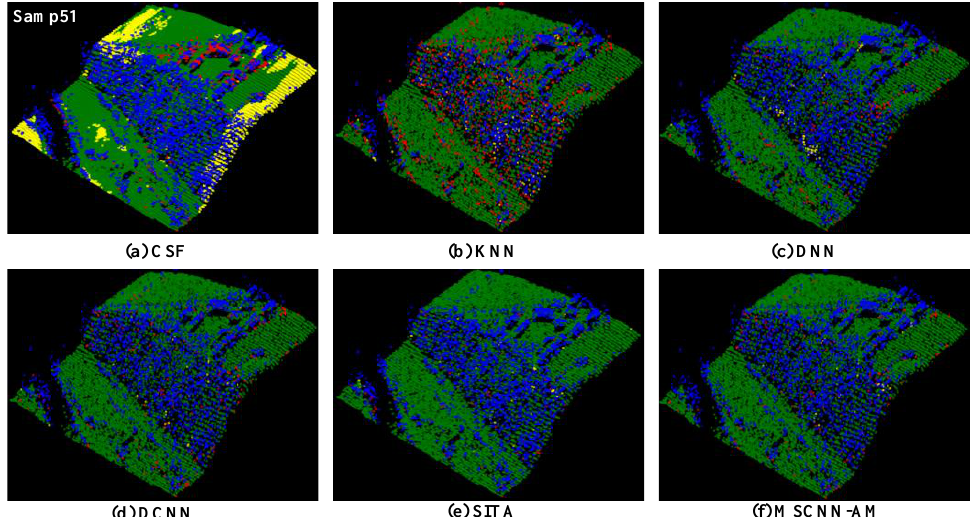
Figure 10. The filtering results of six methods on Samp51. ( a ) CSF; ( b ) KNN; ( c ) DNN; ( d ) DCNN; ( e ) SITA; ( f ) MSCNN-AM.